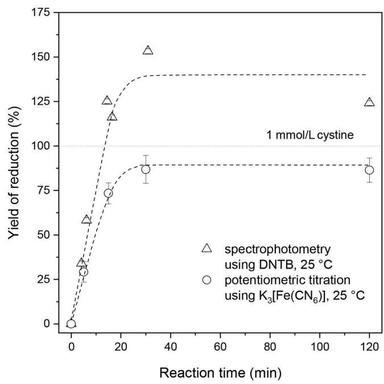
Yield of cystine reduction as a function of reaction time with NaBH4.